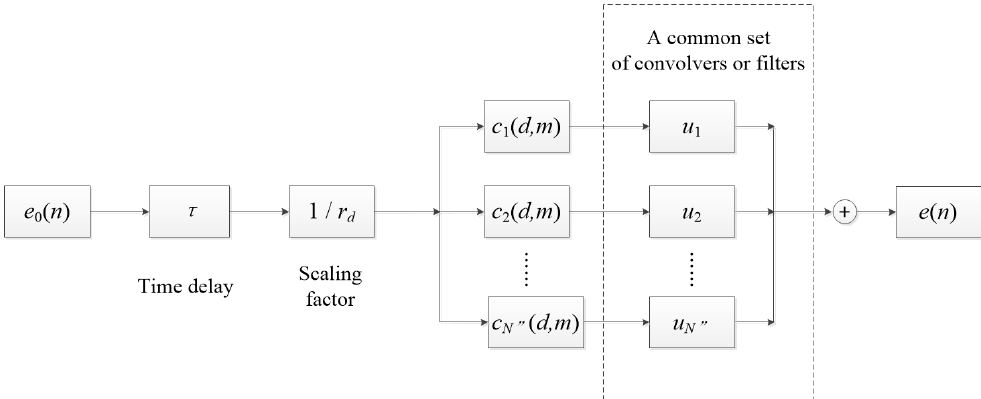
Figure 1. The block diagram of